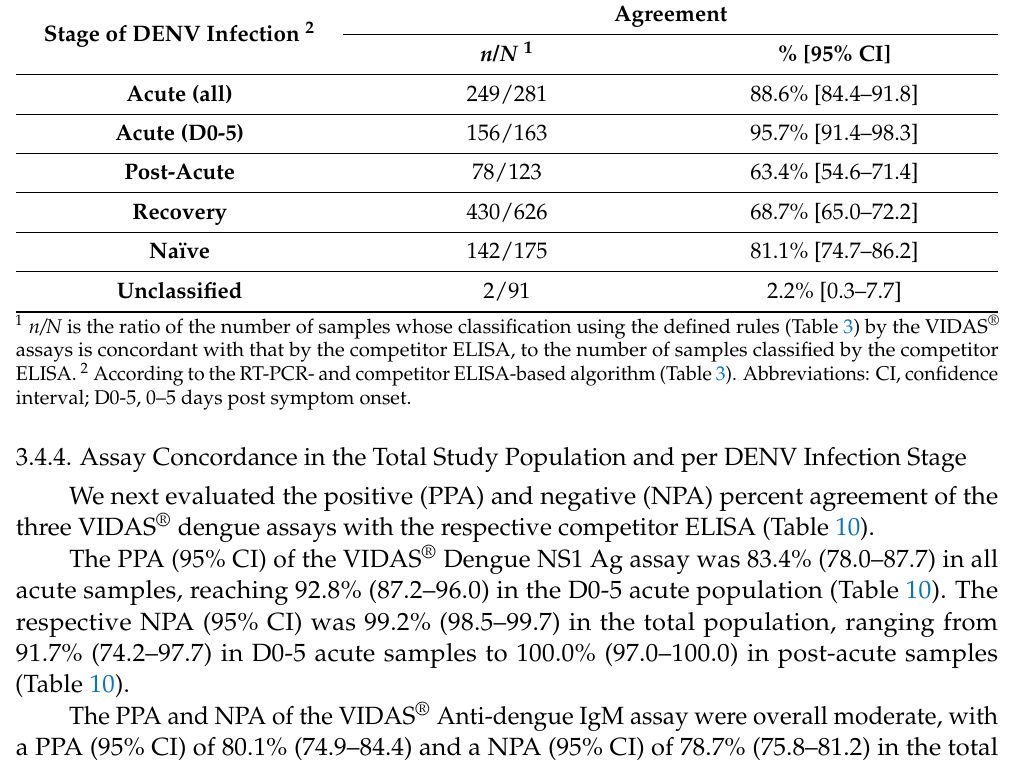
Table 9. Concordance of the infection stage classification by the VIDAS ® -based vs. the competitor ELISA-based algorithm. Stage of DENV Infection